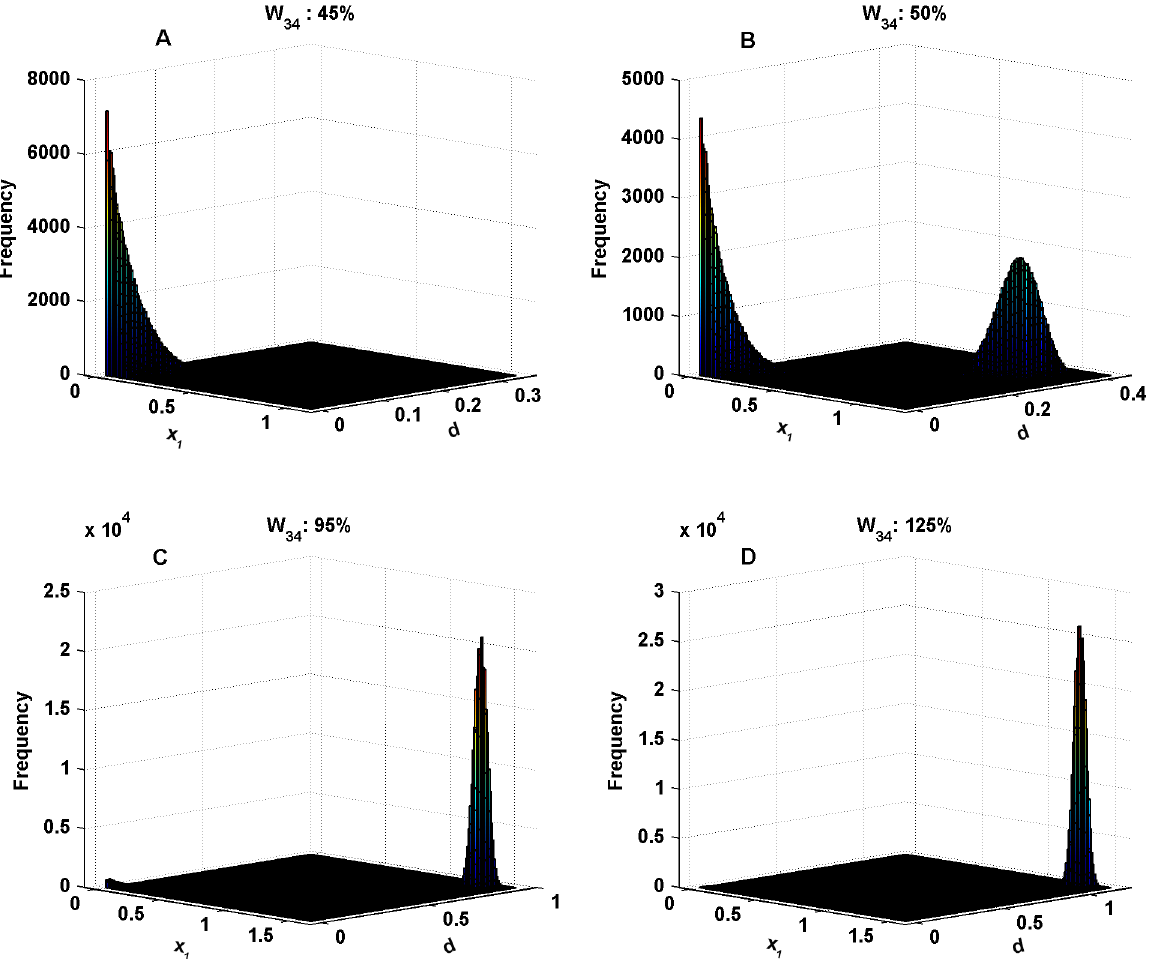
Fig 4. Steady state frequency distributions for different values of dopamine releasability, W 34 . These distributions are obtained by simulating Eqs (7a) – (7d). With increasing W 34 , the curves exhibit a gradual transition of relative sample distributions from lower to higher stable state. Additive noise strengths used here are σ 1 = 0.05, σ 2 = 0.01, σ 3 = 0.001, σ 4 = 0.05, estimated in accordance with the scales of magnitude acquired by the different variables in the circuit